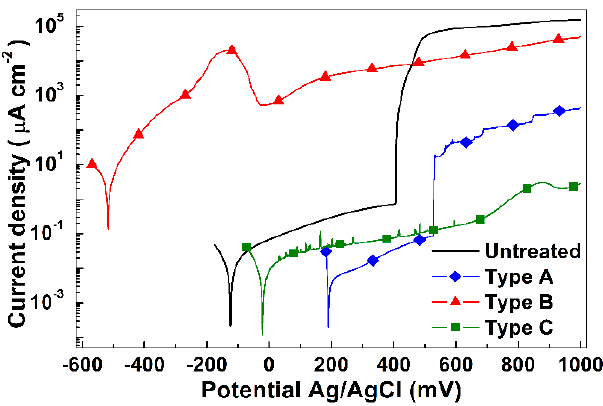
Figure 6. Polarization curves of samples untreated and treated as indicated (solution: 5% NaCl, aerated).